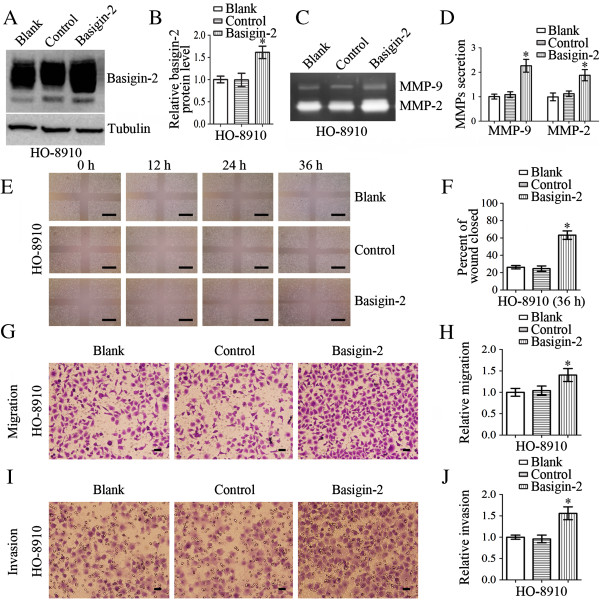
Effects on cellular invasiveness/migration and MMP-9/MMP-2 expressions of HO-8910 cells after transfection with basigin-2. HO-8910 cells were either untransfected (blank), or transfected with pcDNA3.1 (control) or pcDNA3.1-basigin-2 (basigin-2). A-B Western blot demonstrated basigin-2 protein levels were significantly increased after transfection with basigin-2. C-D HO-8910 cells were incubated for 24 h and conditioned media were used for the measurement of MMP-2 and MMP-9 protein levels by gelatin zymography. Zymographic analysis showed increased MMP-2 and MMP-9 activity in basigin-2-transfected HO-8910 cells. E-F Wound healing assay was performed on monolayers of HO-8910 cells transfected with pcDNA3.1-basigin-2. The wound gaps were measured at six reference points along the wound, and the results were expressed as the average wound gap. G-H Overexpression of basigin-2 in HO-8910 cells resulted in an increase in cellular migrate capacity. I-J Overexpression of basigin-2 in HO-8910 cells resulted in an increase in cellular invasive capacity. Scale bars = 0.5 mm (E). Scale bars = 0.1 mm (G, I). Statistical significance was assessed using one-way ANOVA. Data are presented as mean ± SD for three independent experiments. *P < 0.05, statistically significant difference.